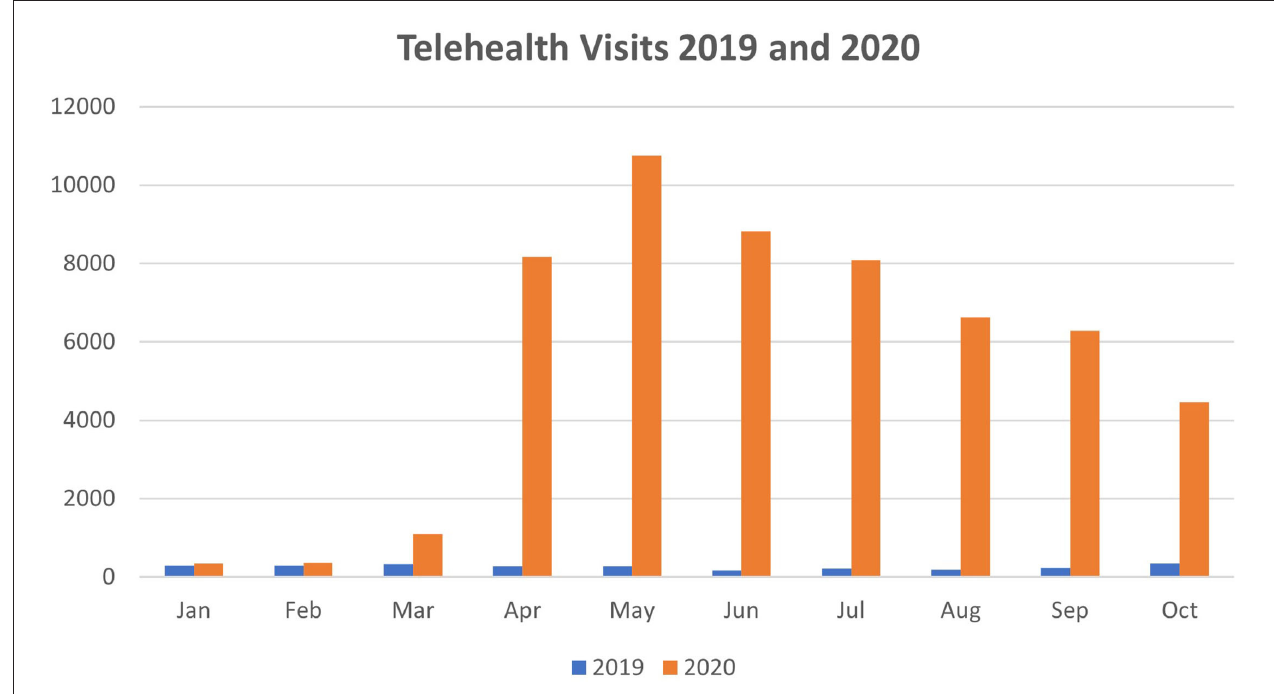
FIGURE 1 | Telehealth visits by month, 2019 and 2020.